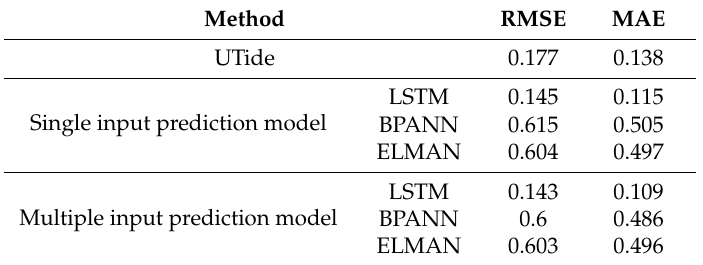
Table 3. Comparison RMSE and MAE of the tidal current velocity prediction 30 m under the sea